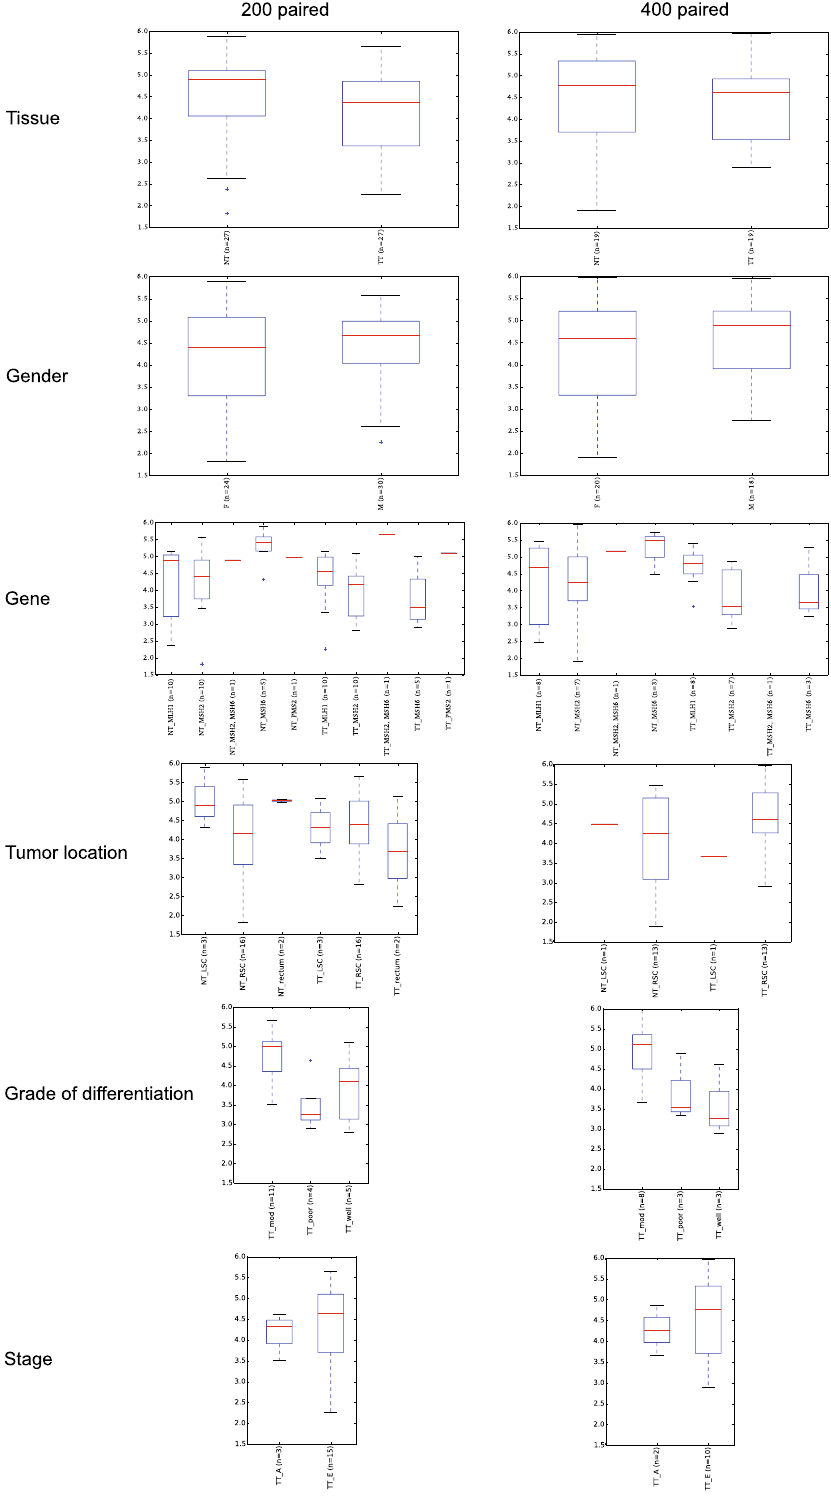
Figure 1. Taxonomic ecological alpha diversity analysis by tissue, gender, gene mutated, tumor tissue, tumor location, grade of differentiation and stage. Analyses are shown for paired-only samples with more than 200 and 400 reads. Diversity within samples is estimated by the Shannon diversity index. In the case of tissue and gender, the p -values of the pairwise comparison is shown, regardless of the significance, whereas in the case of the gene in both normal and tumor tissue, p -values are shown only in significant pairwise comparisons ( p -value < 0.05). NT: normal tissue, TT: tumor tissue; F: female; M: male; LSC: left-sided colon (descending + sigmoid); RSC: right-sided colon (ascending + transverse); E: early stage (I + II); A: advanced stage (III +